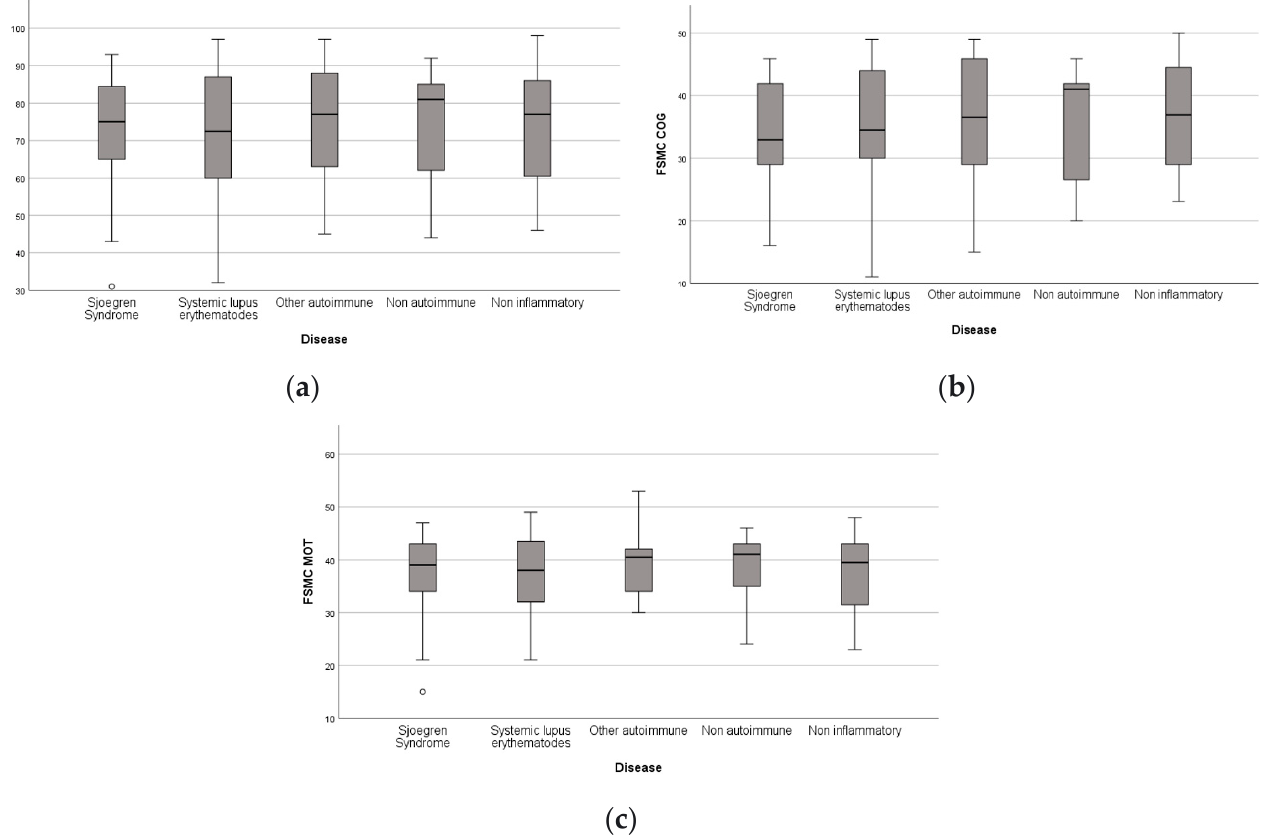
Figure 2. ( a – c ) Severity of total fatigue in patients with positive anti-NR2 titer according to the FMSC score.